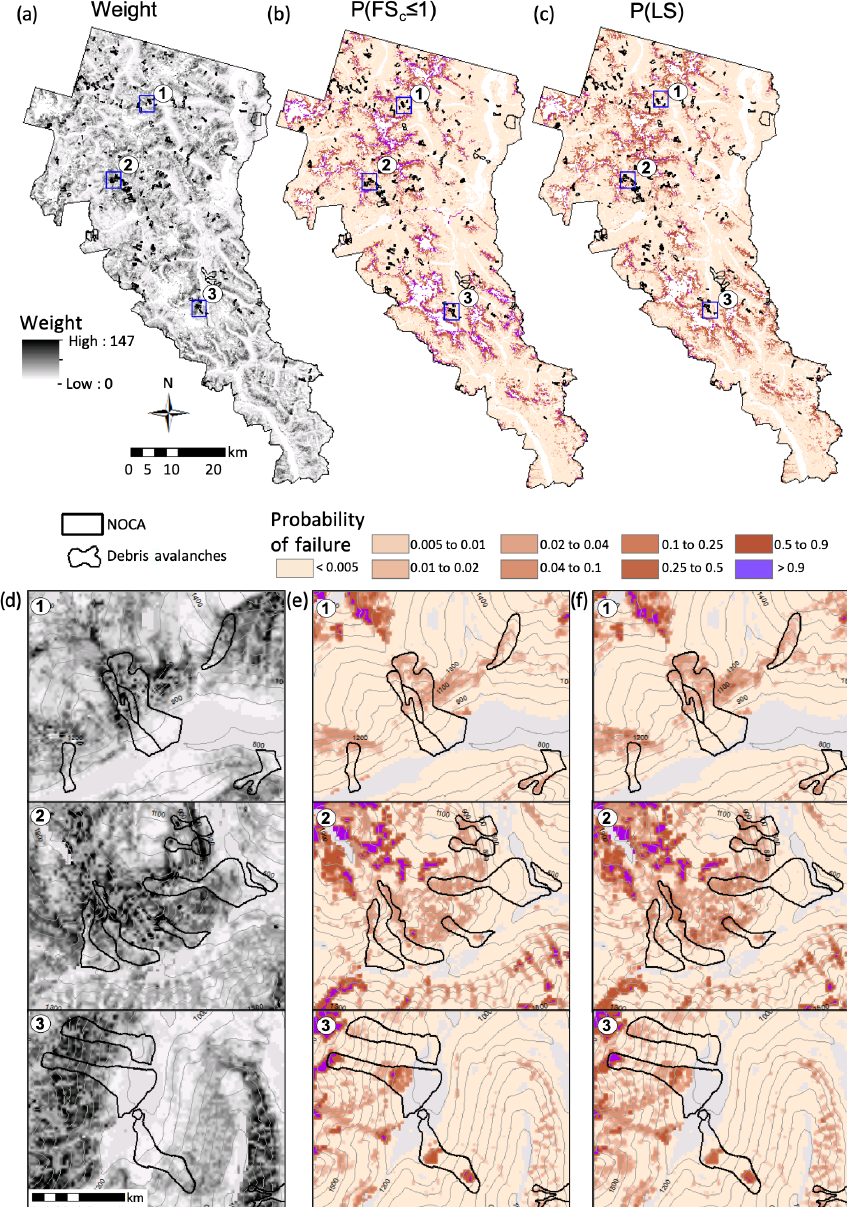
Figure 8. Maps of (a) a weight term derived from joint empirical and physically based modeled probabilities, (b) P (FS c ≤ 1) from Strauch et al. (2018), and (c) P (LS) created from multiplying (a) and (b) at each grid cell for the North Cascades National Park Complex (NOCA). Blue boxes indicate three closeup locations shown below in (d–f) . Black lines show mapped debris avalanche boundaries. Gray areas are excluded from the analysis, and contours are at